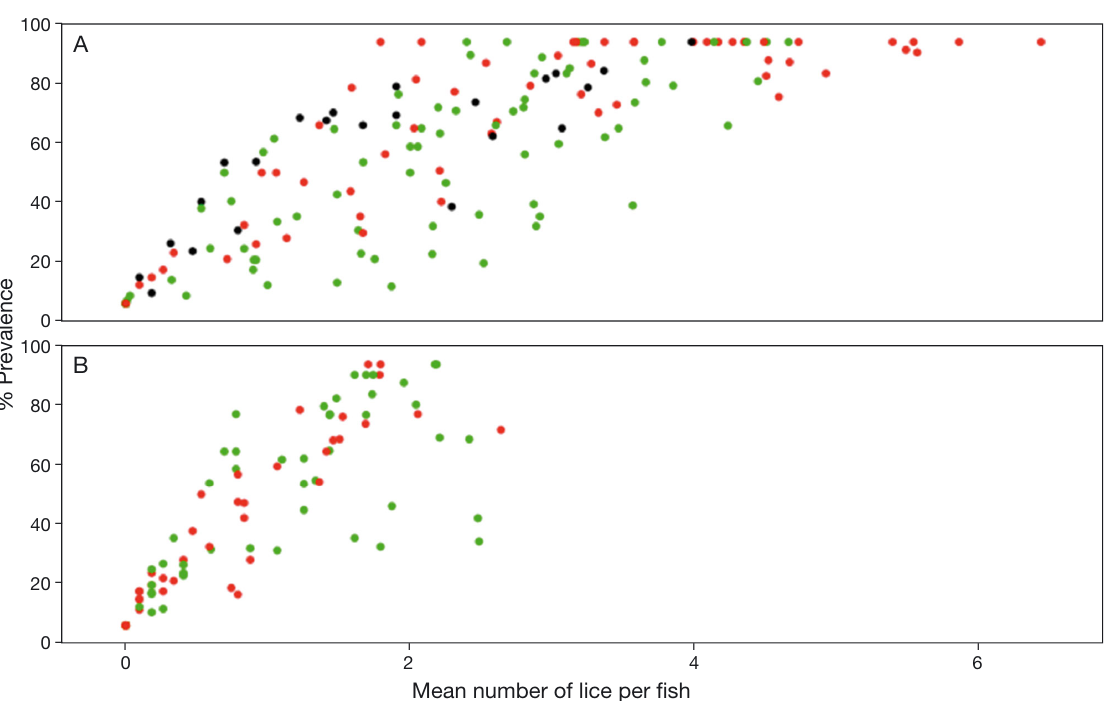
Fig. 3. Relationship between the prevalence and mean number of salmon lice per sea trout sampled in (A) areas where salmon farming was present and, (B) areas without salmon farming. Data sourced from published studies (see references in Fig. 2). Studies performed in Ireland, Norway and Scotland denoted by black, red and green circles, respectively. Mean numbers of lice are